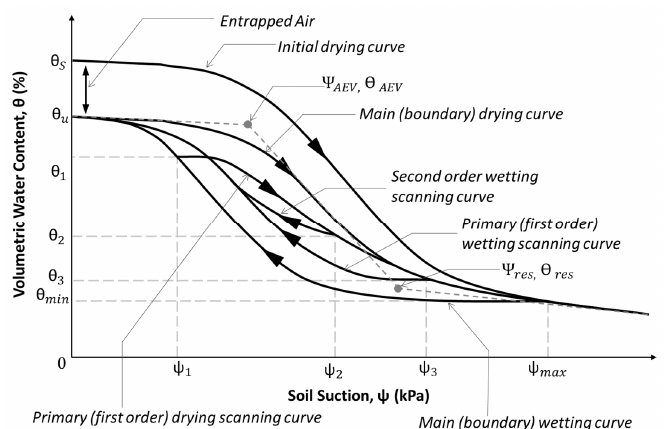
Figure 13. Hysteretic soil water retention curve and associated commonly used definitions (modi ‐ fied after Pham, et al. [72] ). after Pham, et al.